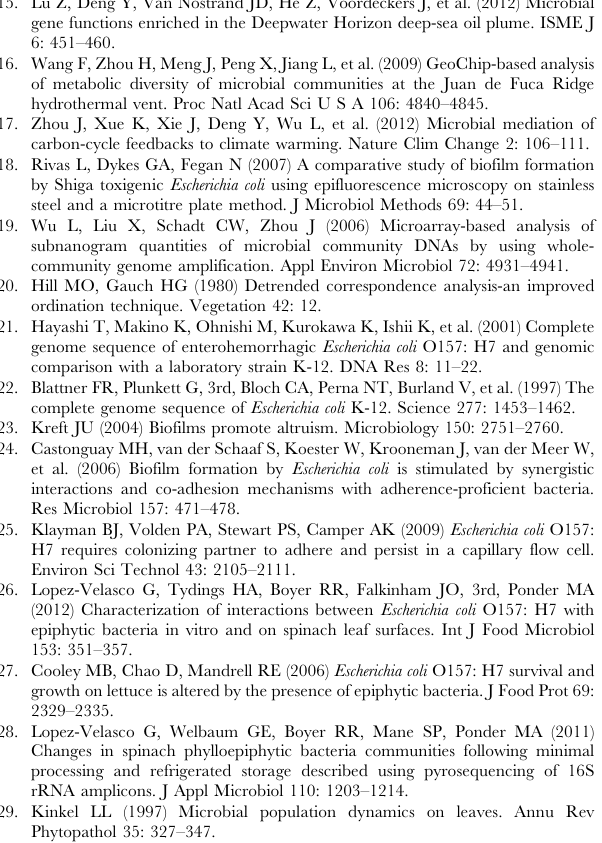
Figure S1 Functional compositions of biofilm commu- nities. (PDF) Figure S2 The gyrB-based phylo-composition of the biofilm community. Figure S3 The impacts of EcO157 on the genes involved in phosphorus utilization in biofilm community. Table S1 ANOVA test of EcO157 biofilm population sizes in various spinach lysates. Table S2 Functional composition of biofilm communi- ties detected with the GeoChip 4.0. Table S3 The gyrB-based phylo-composition of biofilm communities.